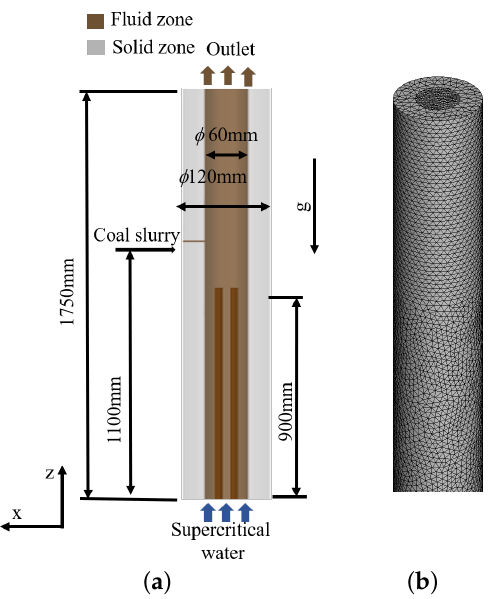
Figure 1. Illustration of ( a ) the SCWFB reactor as well as ( b ) the discrete numerical